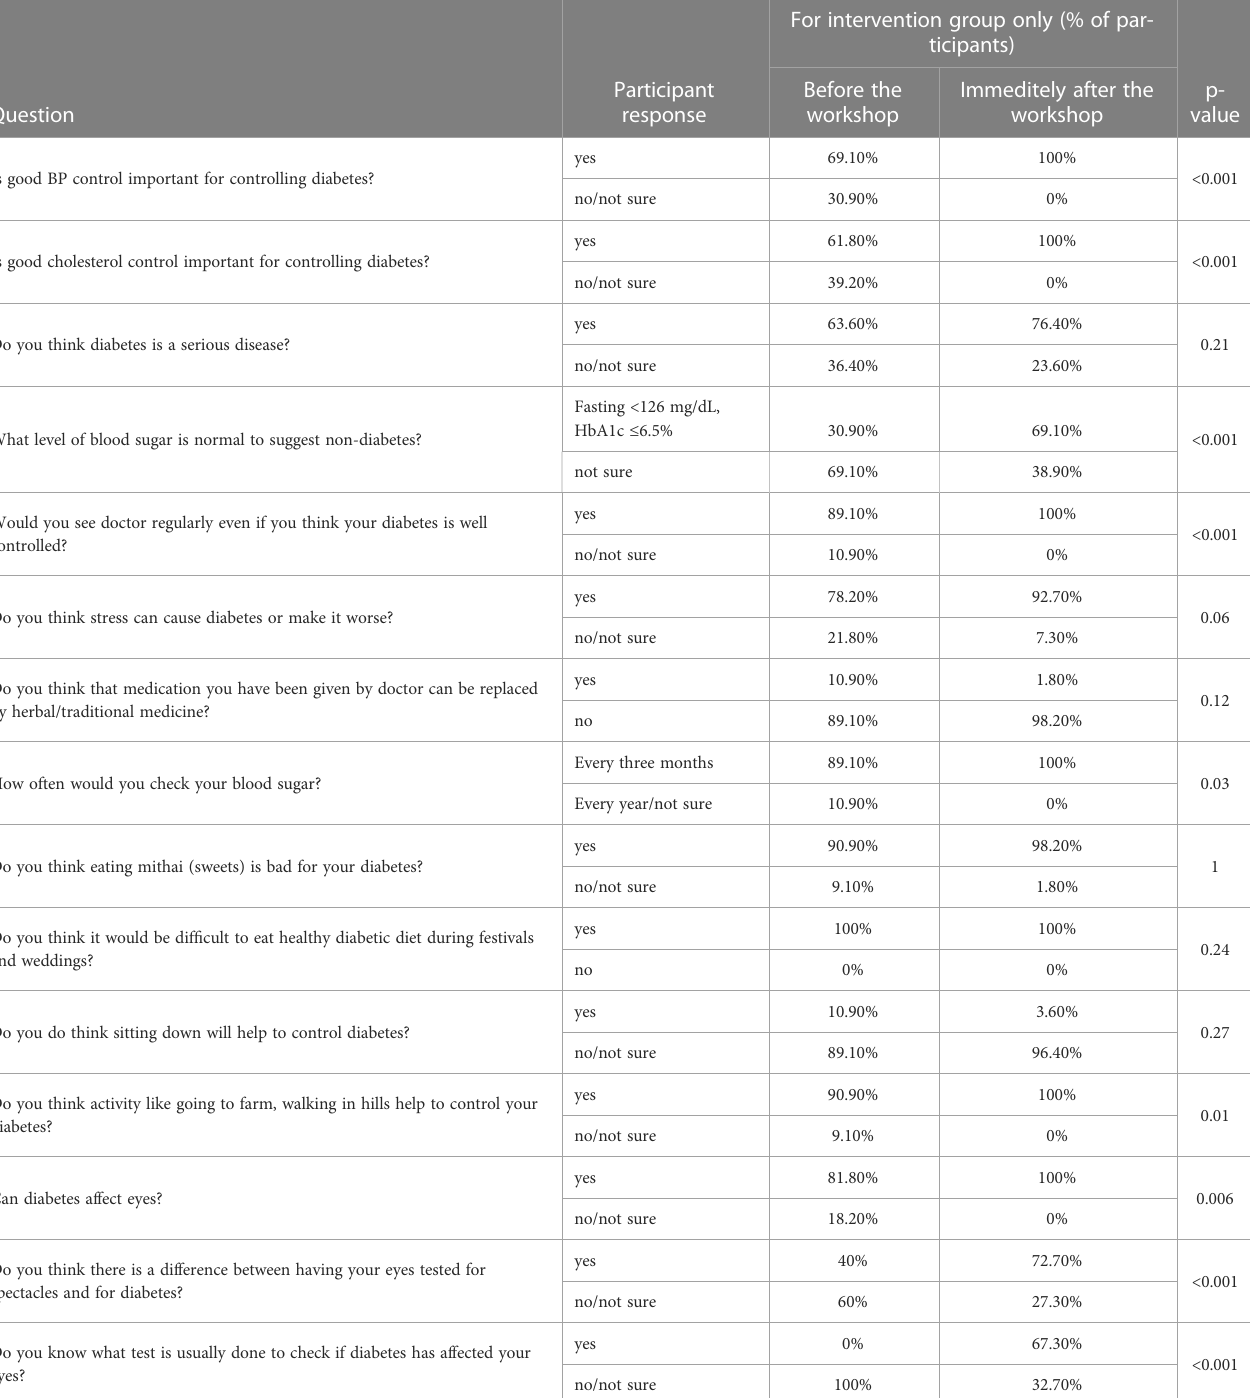
p- valueBefore the